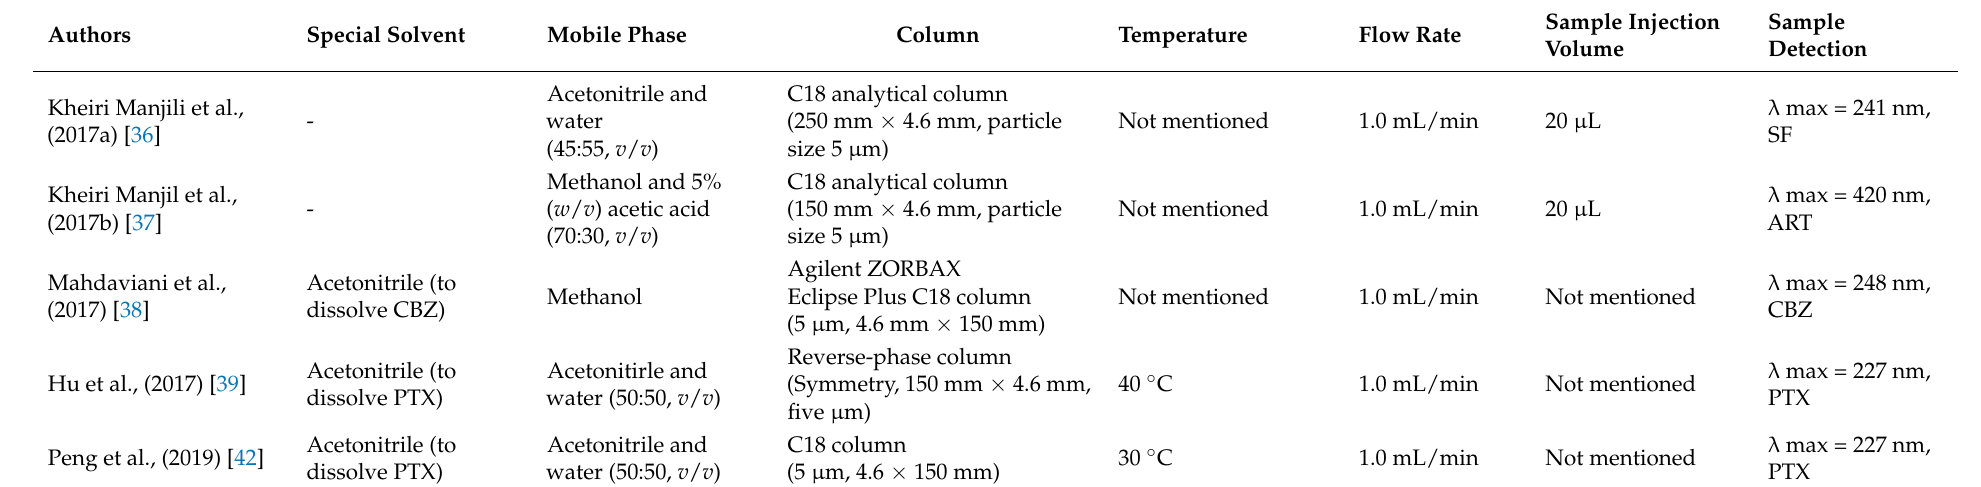
Table 6. HPLC parameters for drug loading and encapsulation efficiency